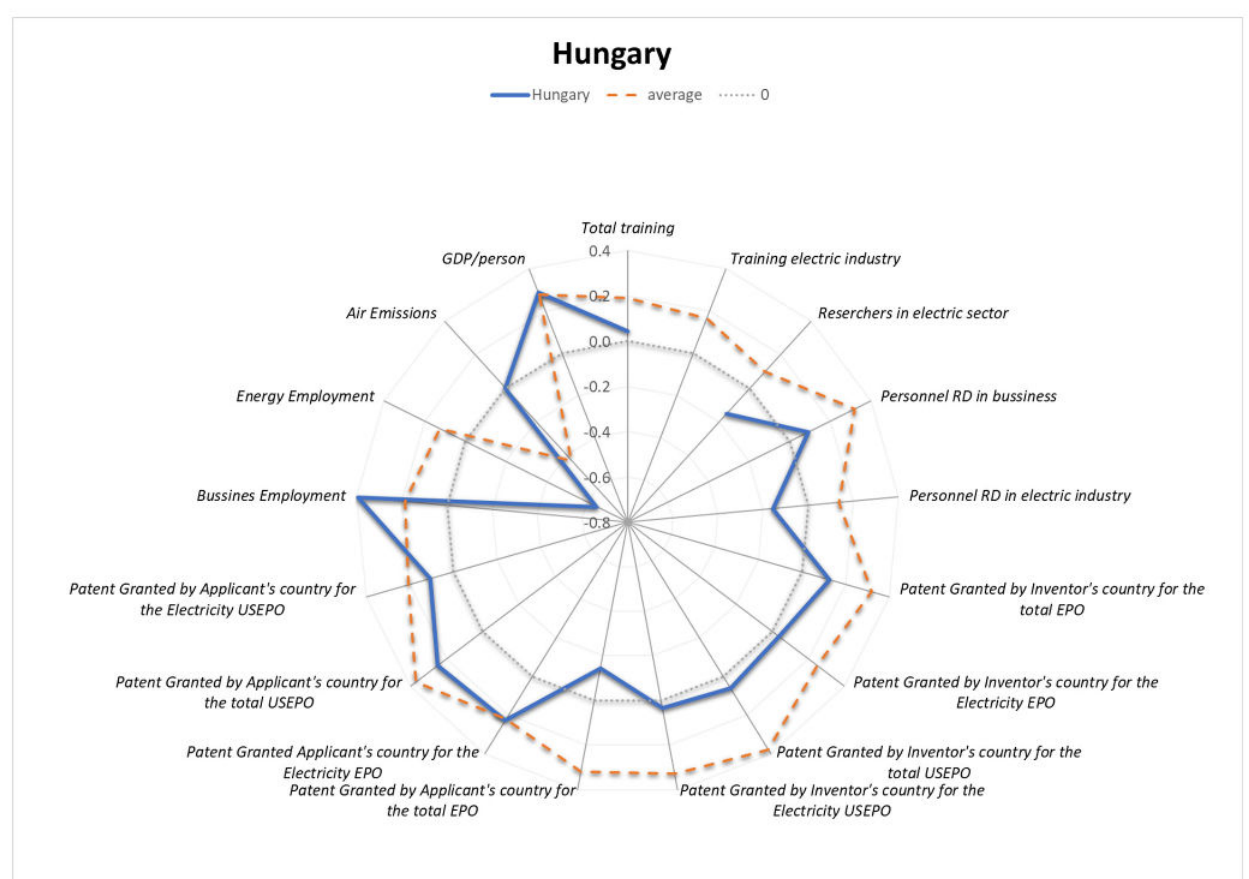
Figure 20. Synergy and trade-off occurrence—HU. Source: Authors’